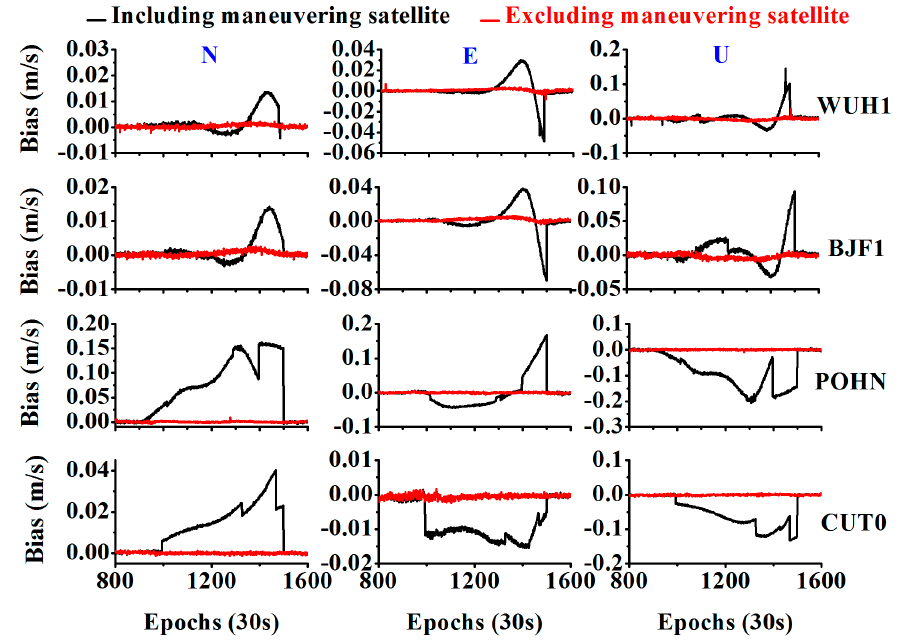
Figure 12. Comparison between the velocity results when including the maneuvering satellite and excluding the maneuvering satellite.